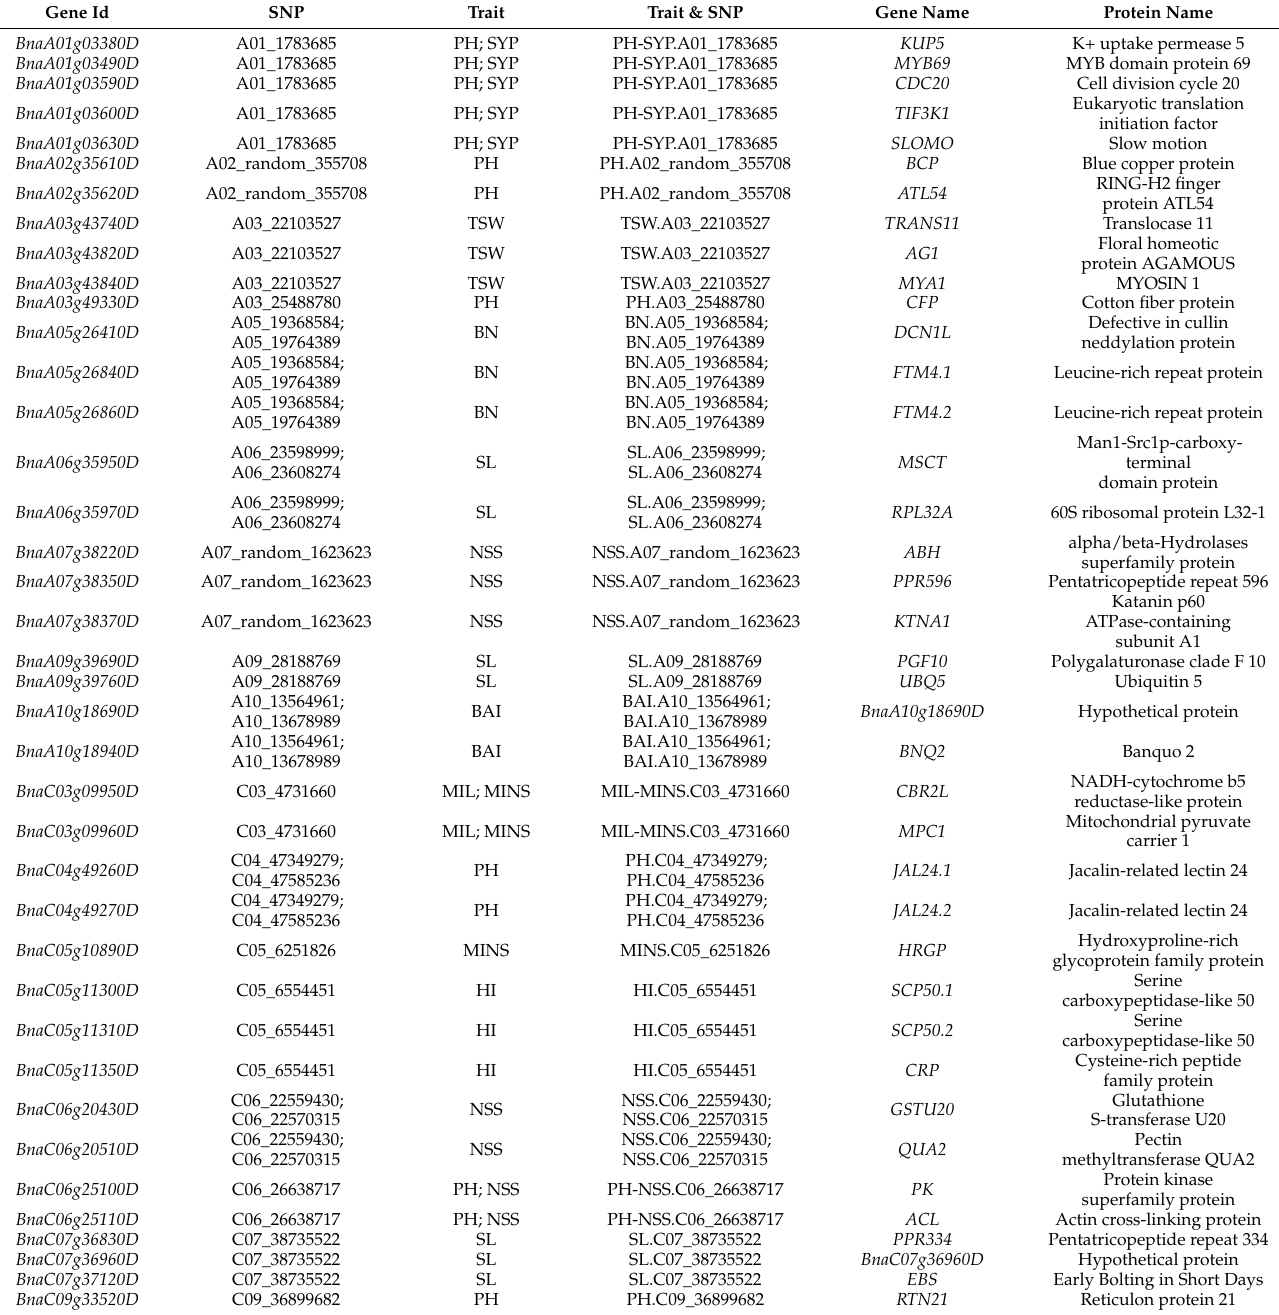
Table 1. Summary of candidate genes predicted for agronomic